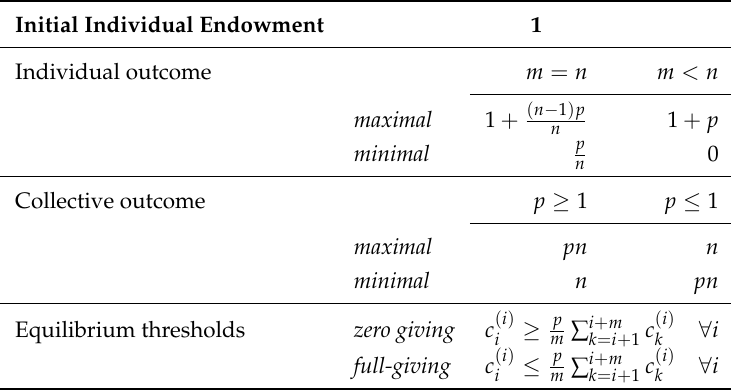
Table 1. Characteristics of the game induced by the m